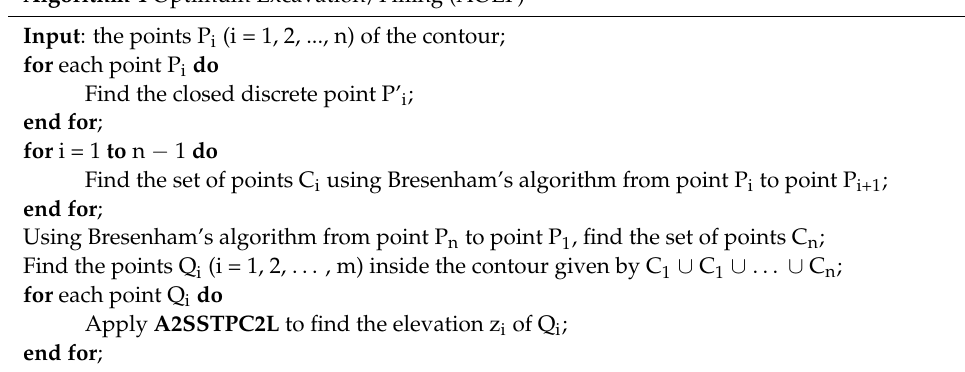
Algorithm 5 Height of Excavation/Filling Plane